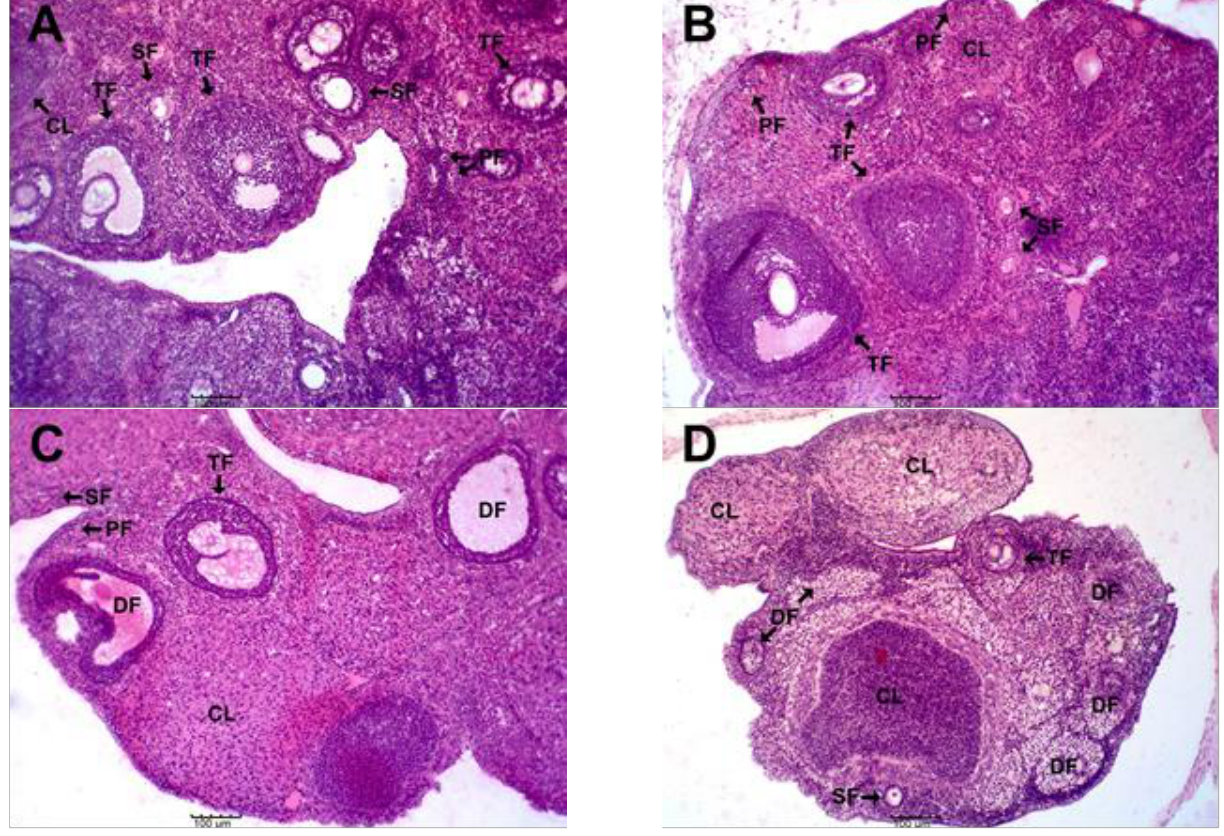
Figure 7. Micrographs of ovarian histology in female albino rats exposed to various doses of methanolic seed extract of AI. Groups ( A , B ) had more developing follicles, while ( C , D ) had an abundance of degenerating follicles in the ovary. H and E staining; scale bar (100 µm). PF = Primordial follicle; SF = Secondary follicle; TF = Tertiary follicle; CL = Corpus luteum; DF = Degenerating follicles. Table 4. Group fertility parameters of adult female albino rats fed graded doses of methanolic extract of Azadirachta indica